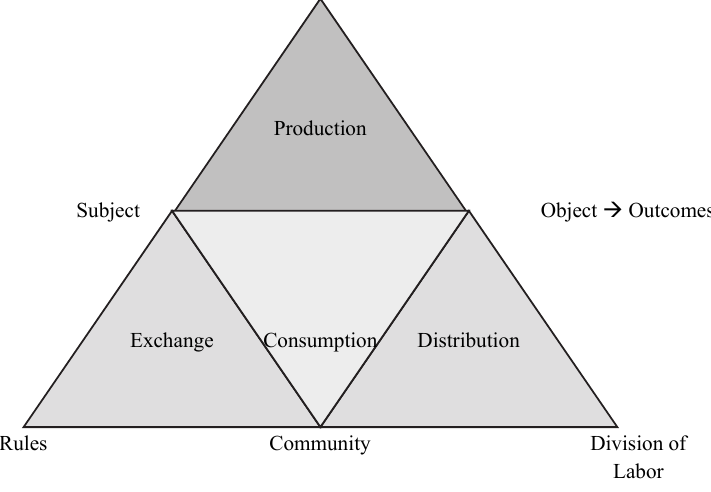
Fig. 1. Generic Activity Systems